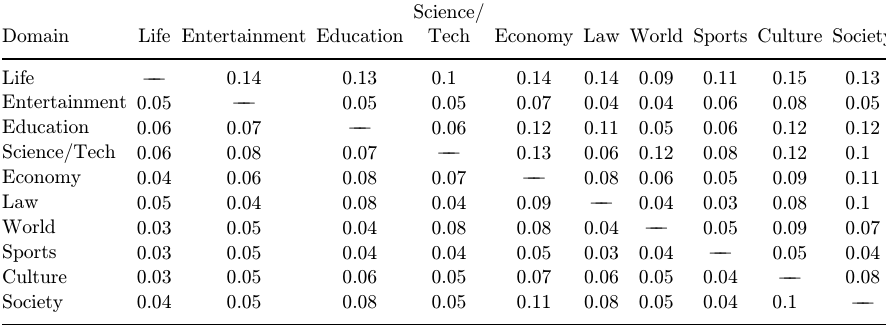
Table 3. Percentage of overlapping entities between the domains in the VLSP2018 dataset.